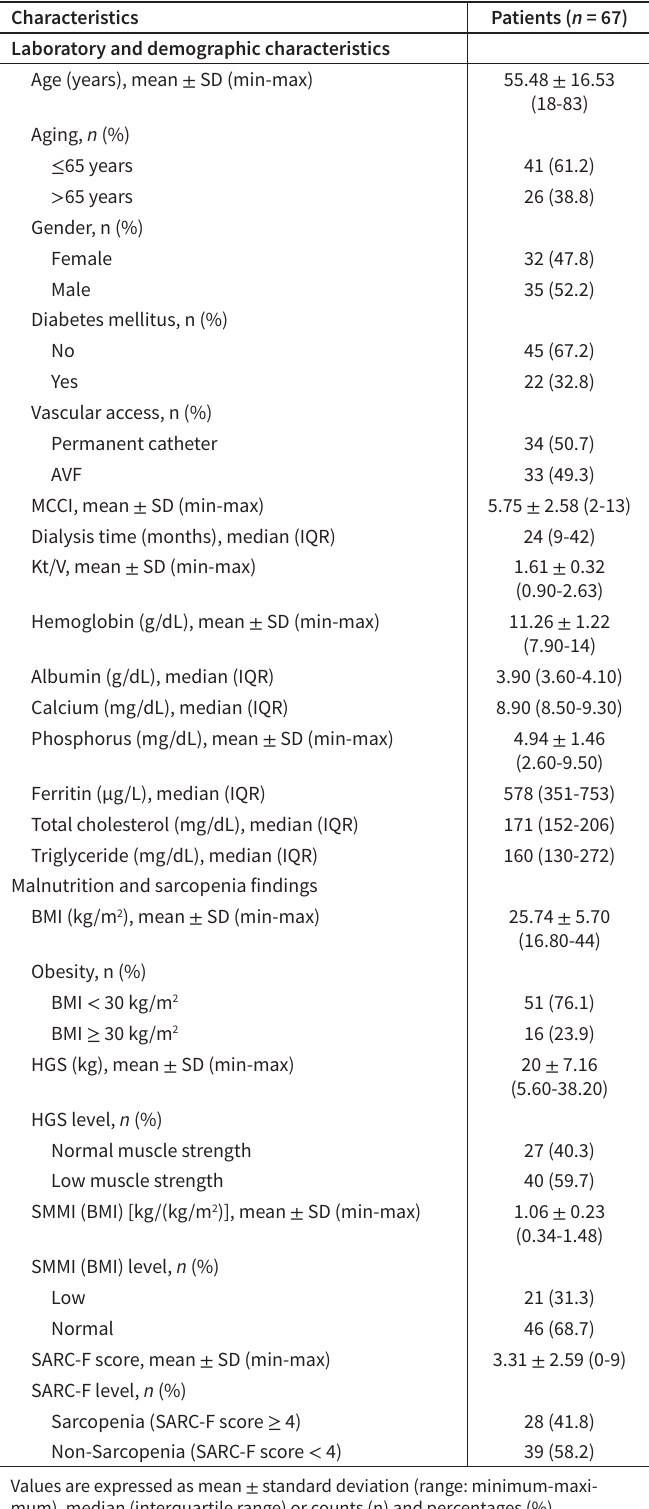
Table 1. The Demographics and Laboratory Characteristics and Malnutrition and Sarcopenia Findings of the Patients